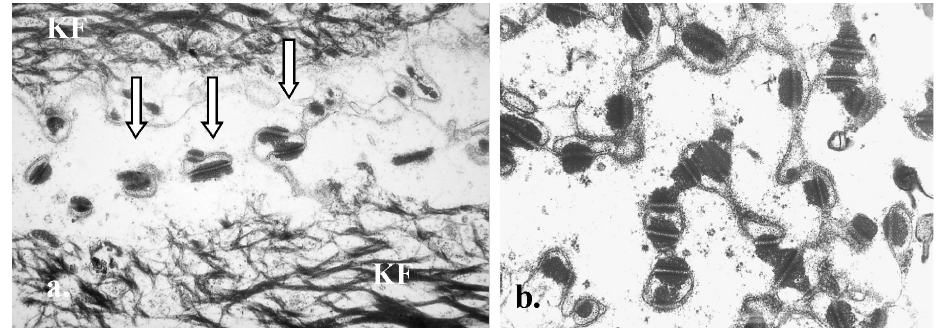
Figure 3 – One hour after the experiment a. Attachment loss of keratin filaments (KF) to the desmosomal plaques (arrows) (x 17.000). b. Free desmosomes without contact with keratin (x 60.000)